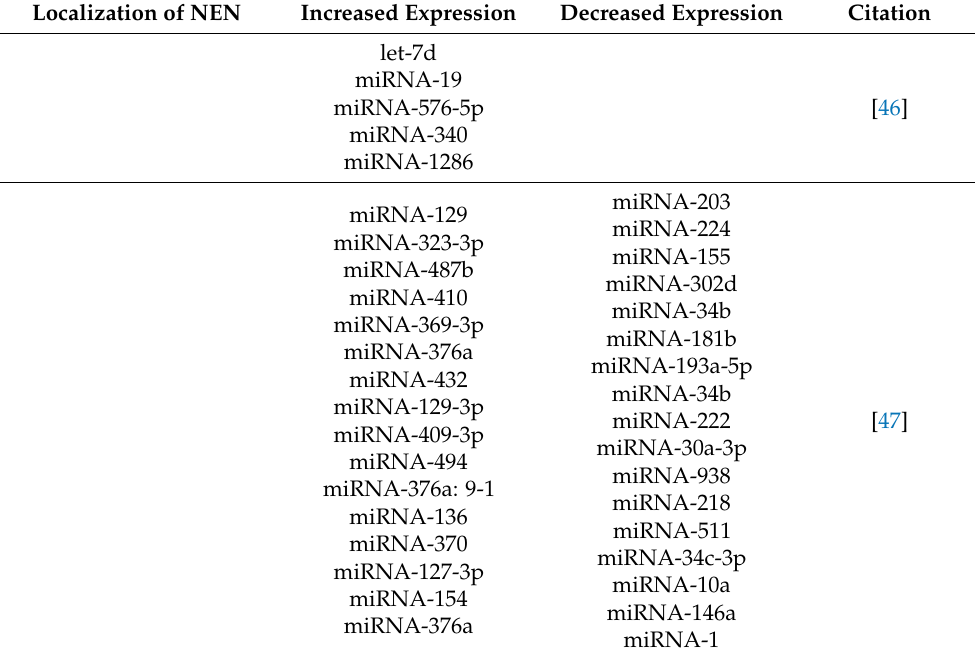
Table 1. Cont. Localization of NEN Increased Expression Decreased Expression Citation